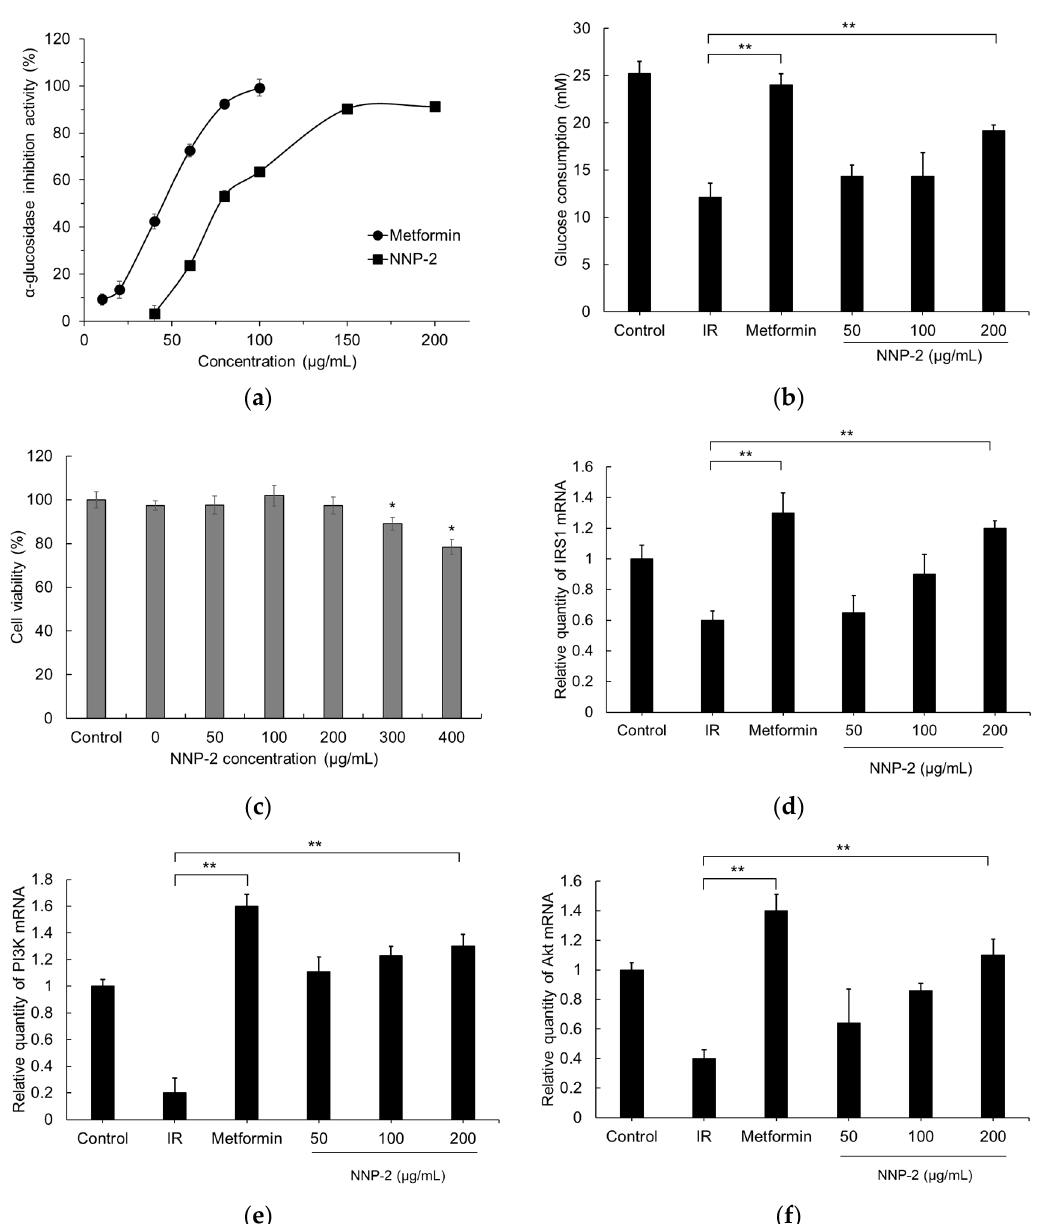
Figure 3. Effect of NNP-2 on inhibition of α -glucosidase activity ( a ) and insulin-stimulated glucose uptake in insulin- resistant HepG2 cells ( b – f ). ( b ) NNP-2 promotes glucose consumption of HepG2. ( c ) Cytotoxic effect of NNP-2. ( d ) NNP-2 regulates expression level of IRS1 mRNA. ( e ) NNP-2 regulates expression level of PI3K mRNA. ( f ) NNP-2 regulates expression level of Akt mRNA. The mRNA expressions were determined using RT-qPCR and normalized with the β -actin expression. Data are expressed as mean ± SD ( n = 6). * p < 0.05 compared with the control group. ** p < 0.01 compared with the IR group. IR, insulin resistance cells.